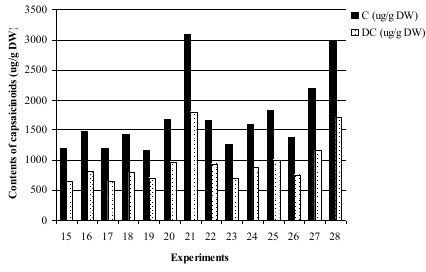
Figure 2. Contents of capsaicinoids obtained from various conditions of ASE using 80%